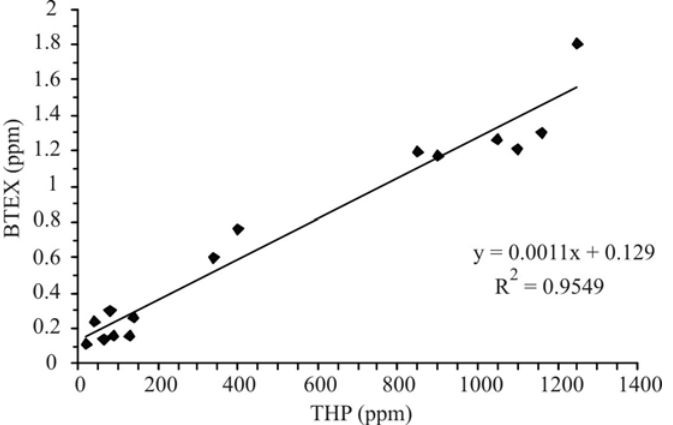
Fig. 2. Correlation between volatile aromatic fraction (BTEX) and total petroleum hydrocarbons (TPH) in contaminated soil and sediment samples Table 2. Minimal risk levels (MRL) and cancer classification for total petroleum hydrocarbon (TPH) components